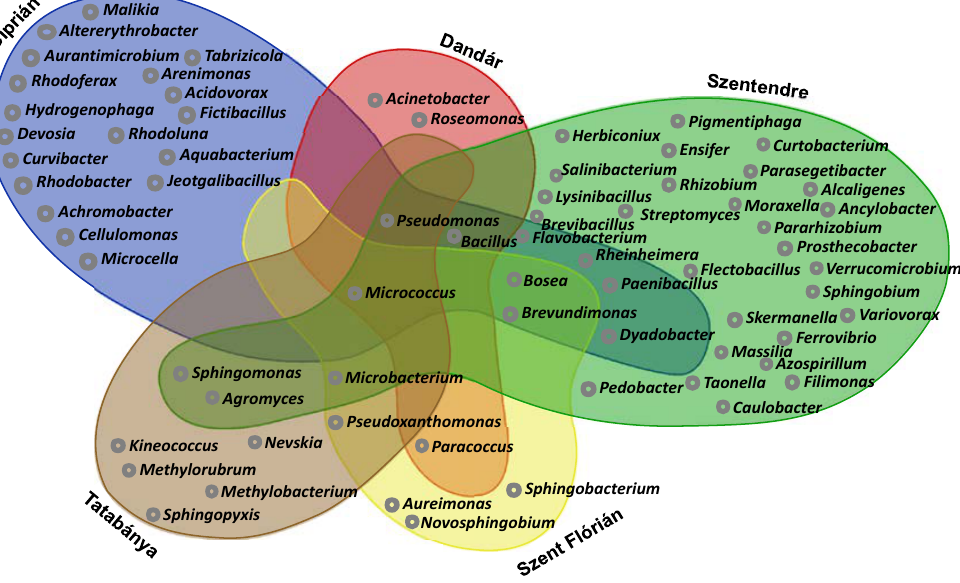
Figure 4. Distribution of the cultivated taxa among the water samples.